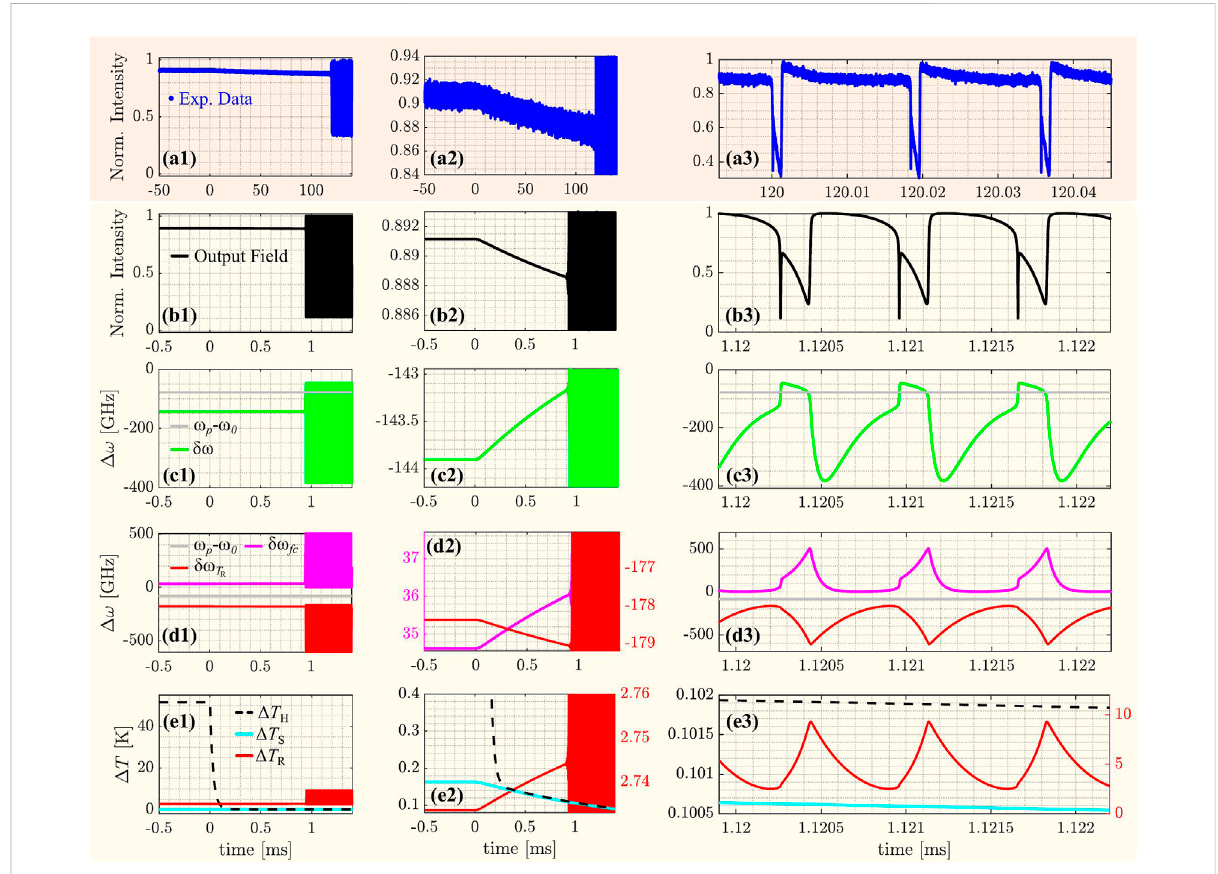
FIGURE 4 Microresonator through port transmission in the non-linear regime and for ω p shifted of about − 80 GHz with respect the cold resonance. Panels (a1 – a3) show the experimental data for the packaged chip. (a2) is a blow-up of (a1) on the intensity scale. (a3) is a blow-up of (a1) in the time interval around 120 ms. (b1 – b3) to (e1 – e3) refer to the numerical simulation results. (b1 – b3) report the simulated through signal (black lines). (c1 – c3) displaytheresonanceshift δω asafunctionoftime(greenline). ω p isshownasthegrayhorizontalline. (d1 – d3) showtheresonanceshift red line), separately. (e1 – e2) due to the free carriers concentration ( δω fc , pink line) and due to the variation of the microresonator temperature ( δω T R showthetimeevolutionofthetemperaturedifferencebetweenthemicroresonatortemperatureand T 0 ( Δ T R ,redline),themicroheatertemperature and T 0 ( Δ T H ,dashedblackline),thesubstratetemperatureand T 0 ( Δ T S ,lightblueline).Forclarityinpanel (d2) thecurvesarerepresentedthroughtwo y -axes:one leftinpink to show δω fc and one rightin redto show δω T . The same for (e2) and (e3) where theleftaxis inblack isrelated to Δ T S and Δ T H R while the right red axis is related to Δ T R